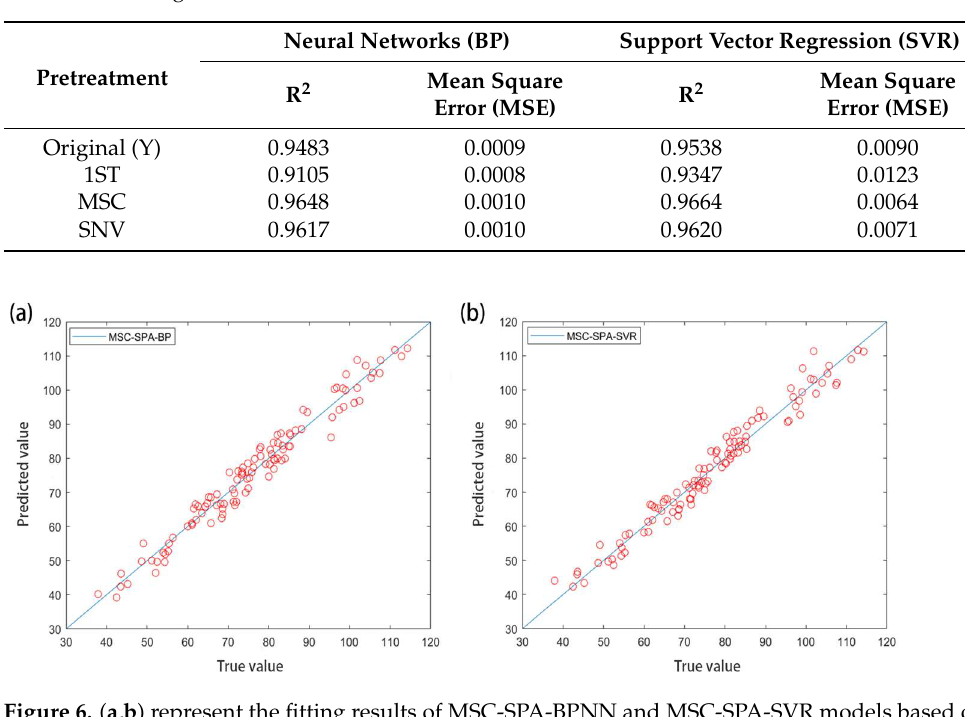
Figure 6. ( a , b ) represent the fitting results of MSC-SPA-BPNN and MSC-SPA-SVR models based on feature bands, feature bands, respectively.